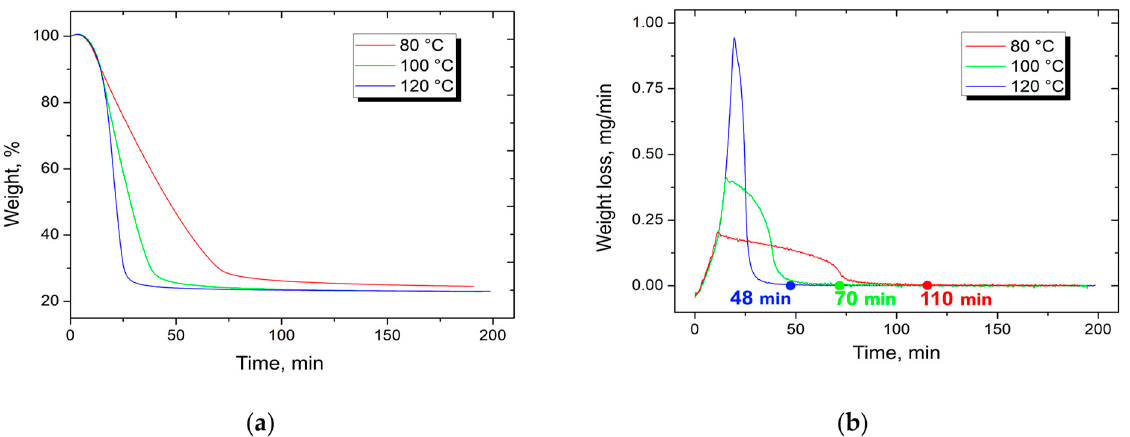
Figure 1. TGA curves, showing ( a ) residual weight percentage and ( b ) weight loss during evaporation of solvent from 20 wt. % PES/N-methyl-2-pyrrolidone solutions. Obtained by the molding of sliced prepregs at 350 ◦ C for 30 min under a pressure of 10 MPa; samples of the composite materials with fiber contents of 70, 60, 50, and 40 wt. % (marked as 70/30, 60/40, 50/50, and 40/60, respectively) were cut to a testable shape. The mold with the samples was cold in the atmosphere of air. These molding conditions are commended as best for PES by Ultrason. Figure 2 shows the scheme for obtaining of the composite